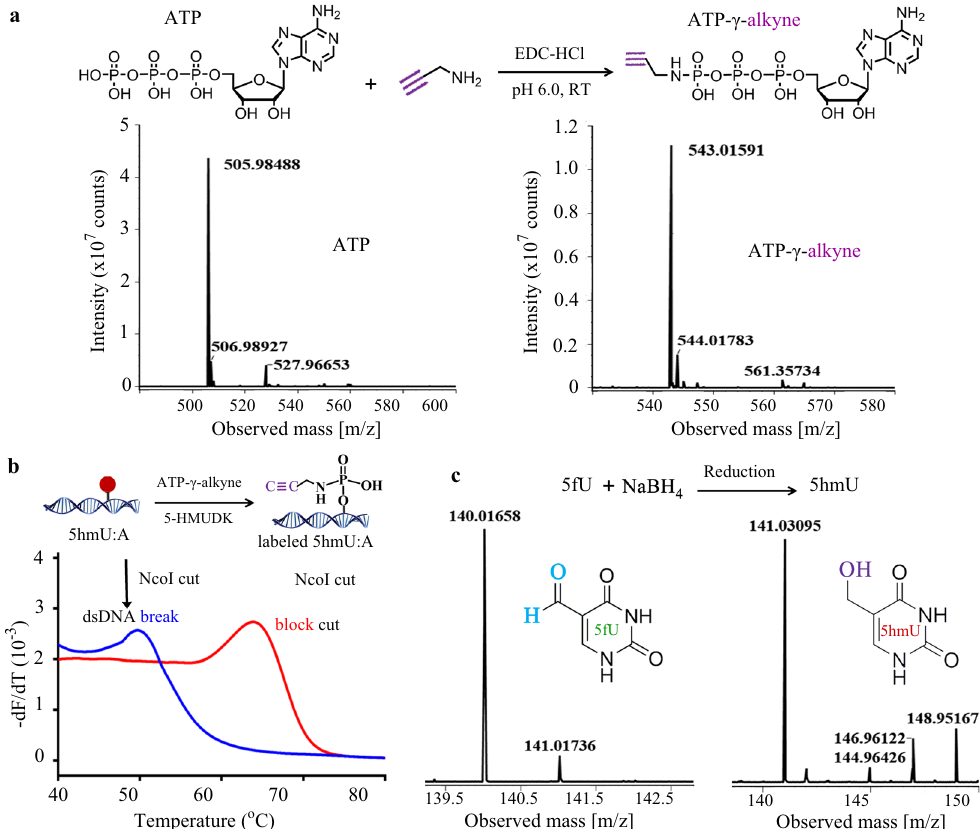
Fig. 3 Synthesis of ATP- γ -alkyne and labeling of DNA modi fi cations. a MS characterization of ATP- γ -alkyne synthesis. Left panel, the mass spectrum of ATP (C 10 H 15 N 5 O 13 P 3 , [M + H] − : 505.98847, calculated; 505.98488, found); right panel, the mass spectrum of ATP- γ -alkyne (C 13 H 18 N 6 O 12 P 3 , [M + H] − : 543.02010, calculated; 543.01591, found). b Melting curve analysis of the cleavage products of 5hmU-contained dsDNA after labeled by 5-HMUDK and ATP- γ -alkyne. c MS characterization of 5fU reduction. Left panel, the mass spectrum of 5fU (C 5 H 4 N 2 O 3 , [M + H] − : 140.02274, calculated; 140.01658, found); right panel, the mass spectrum of reduction product 5hmU (C 5 H 5 N 2 O 3 , [M + H] − : 141.03057, calculated; 141.03095,